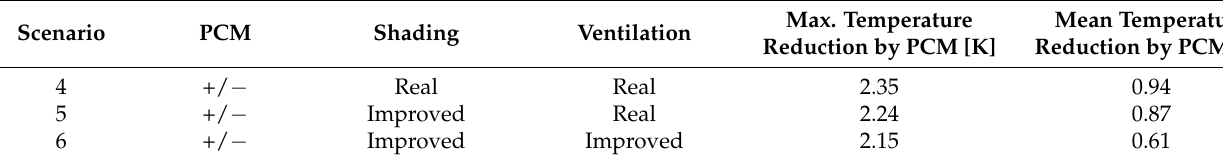
Table 4. Simulation results of different behavioural scenarios and influence of PCM for the class- room from June through September. Temperature reductions indicated are due to PCM scenario (+) compared to scenario without PCM ( − ), respectively.